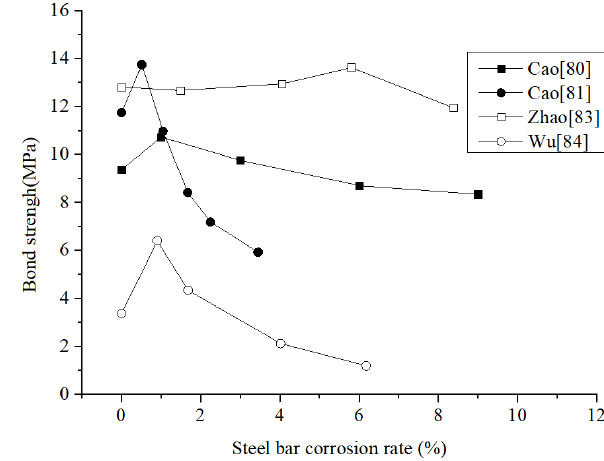
Figure 11: Bond strength versus freezing and thawing cycles. Figure 12: Bond strength versus steel bar corrosion